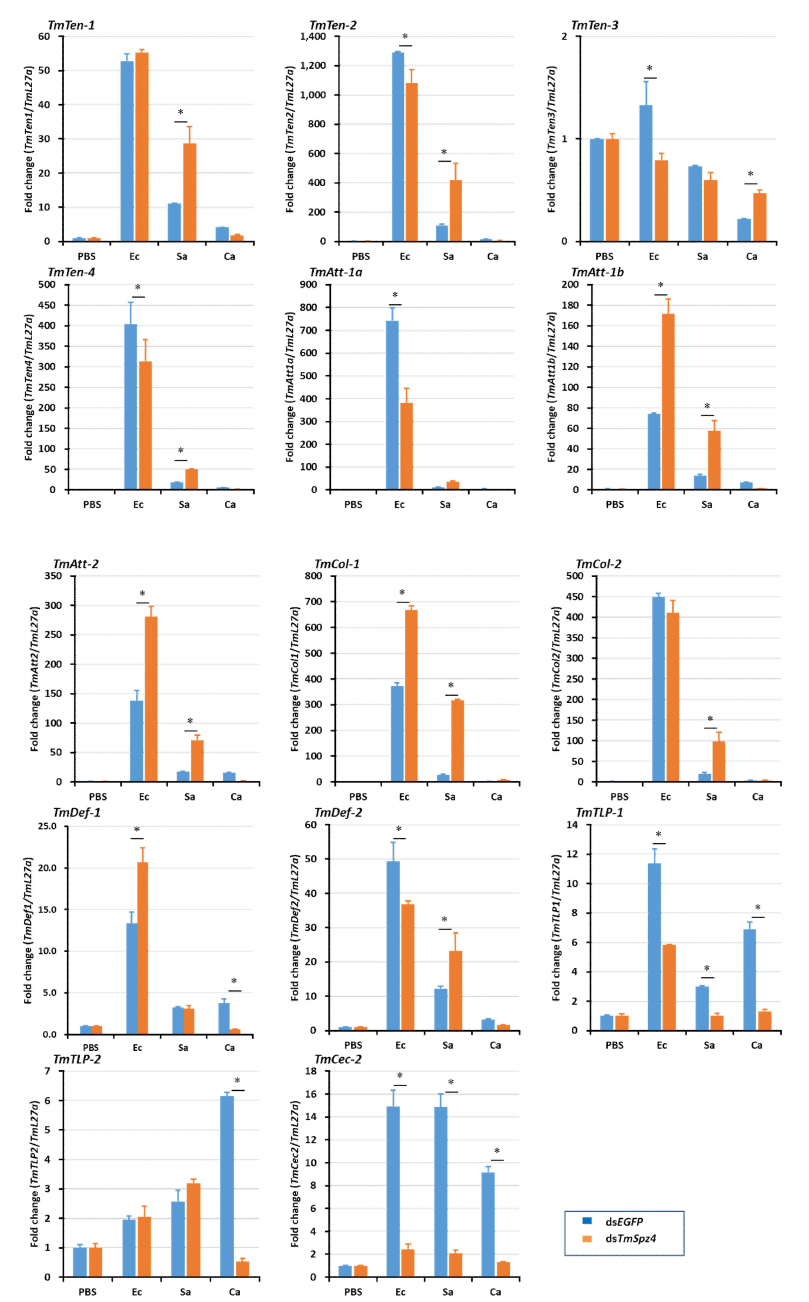
Figure 6. Antimicrobial peptide (AMP) induction patterns in fat body of TmSpz4 -silenced larvae. AMP gene expression levels in the fat body of TmSpz4 -knock-down T. molitor larvae were assessed after injection with E. coli (Ec), S. aureus (Sa), or C. albicans (Ca). PBS was injected as a control 5 days post- TmSpz4 silencing. At 24 h post-microbial challenge, the expression levels of several AMP genes, including those of TmTen-1 , TmTen-2 , TmTen-3 , TmTen-4 , TmAtt-1a , TmAtt-1b , TmAtt-2 , TmDef-1 , TmDef-2 , TmCol-1 , TmCol-2 , TmCec-2 , TmTLP-1 , and TmTLP-2 , were measured by qRT-PCR. ds EGFP was injected as a negative control, and TmL27a expression was measured as an internal control. All experiments were performed in triplicate. Asterisks indicate significant di ff erences between ds TmSpz4- and ds EGFP- treated groups when compared by Student’s t -test ( p <